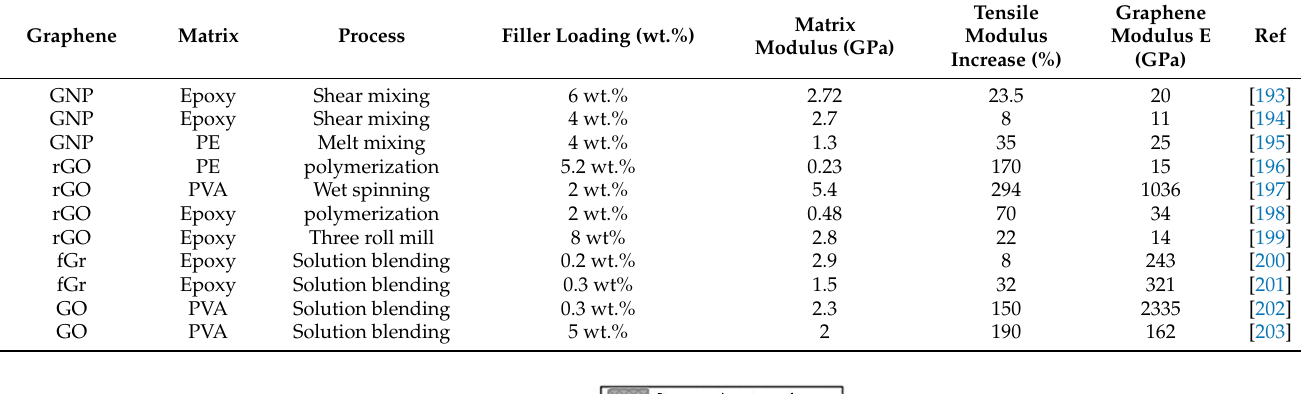
Table 1. Mechanical properties of graphene polymer nanocomposites.